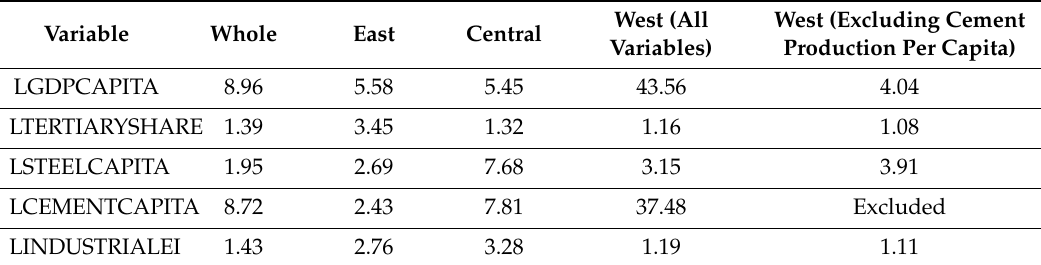
Table 7. Results of the variance inflation factor (VIF)